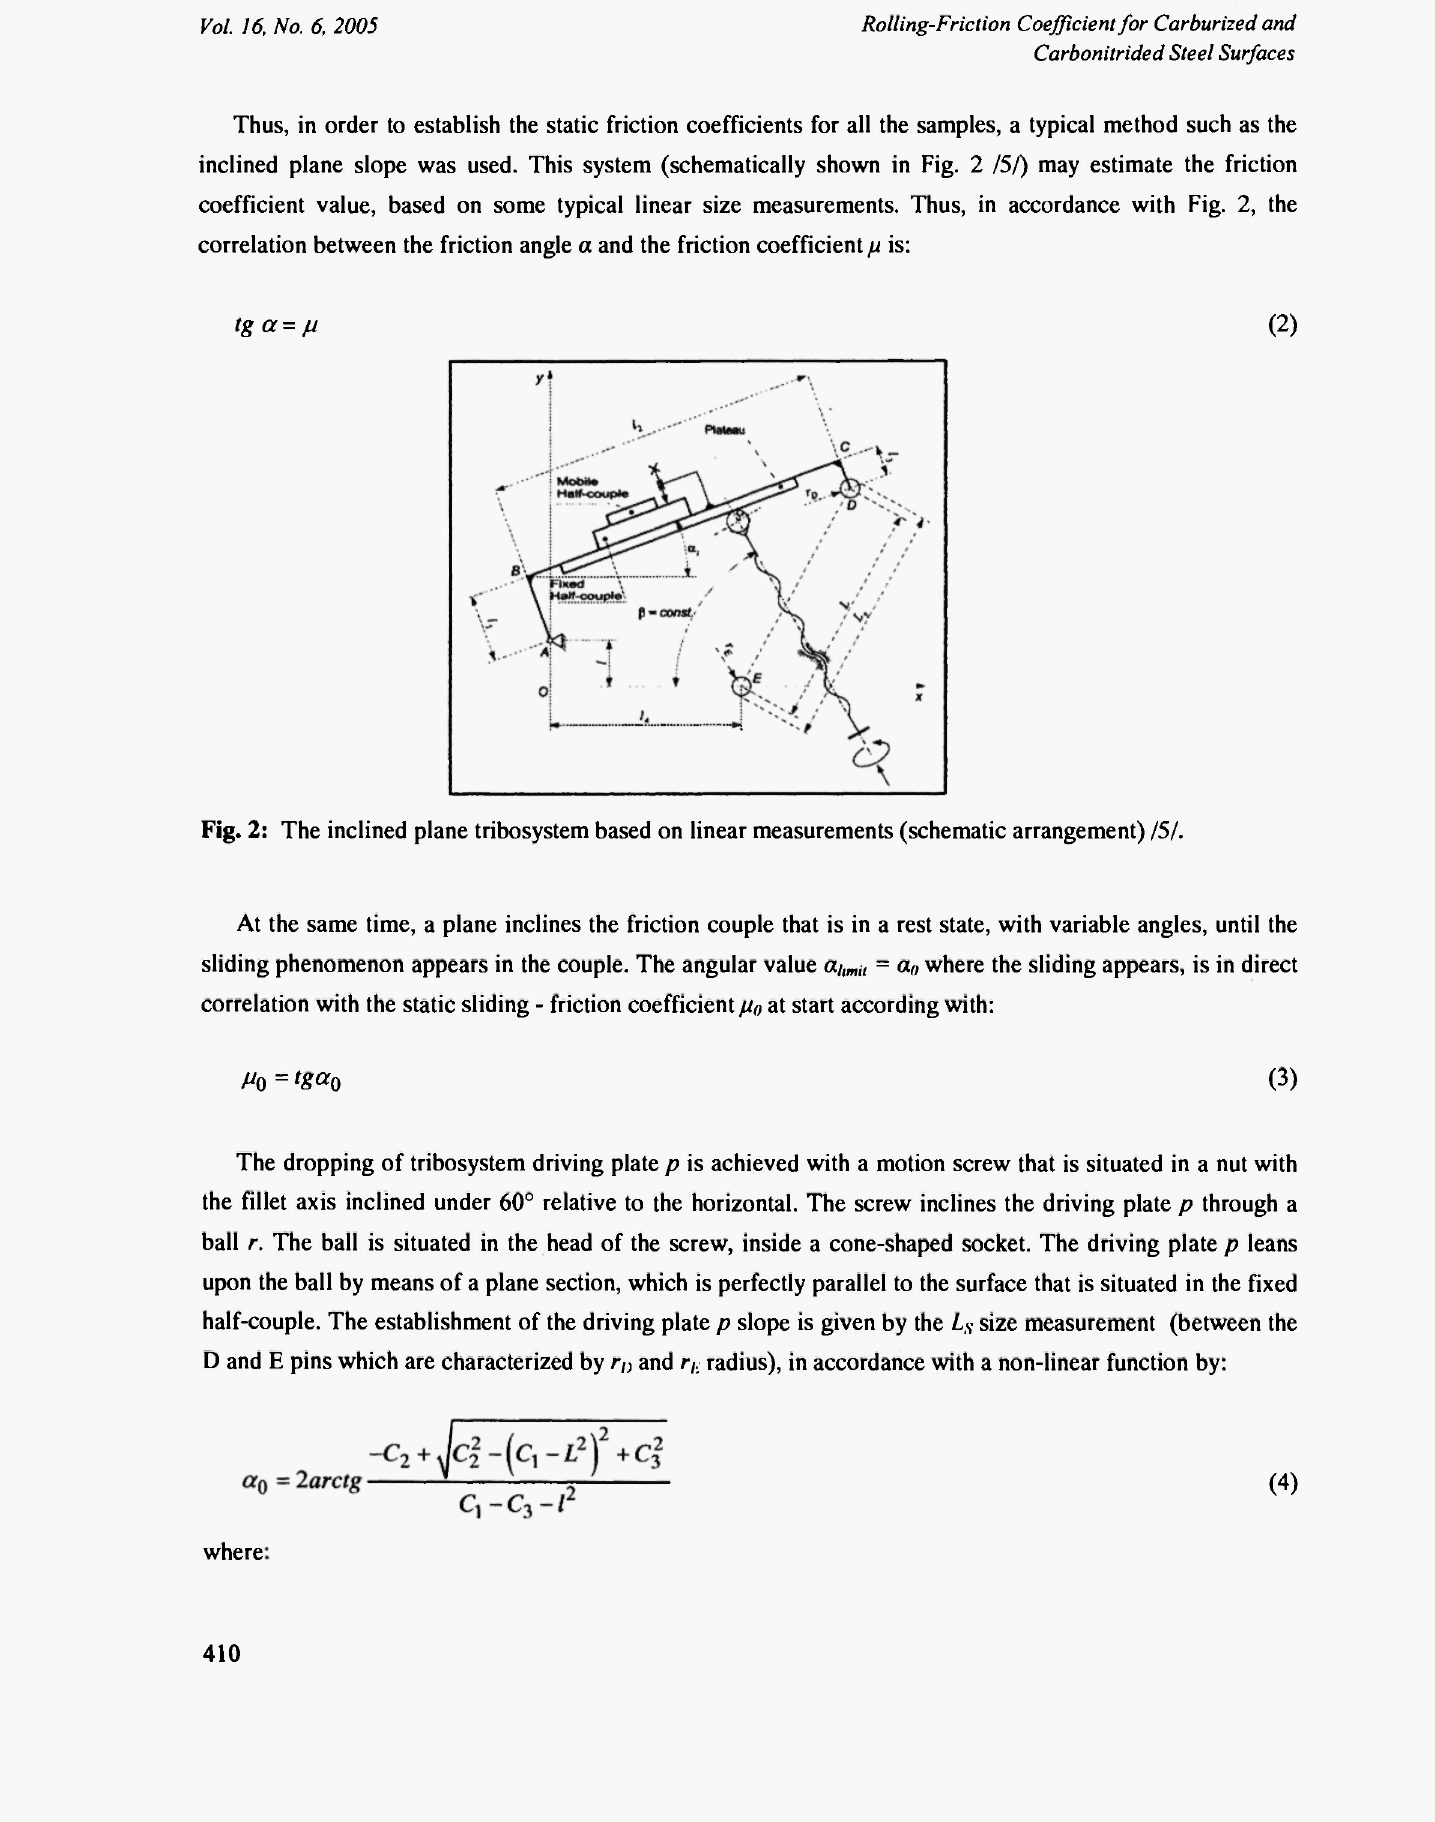
The dropping of tribosystem driving plate ρ is achieved with a motion screw that is situated in a nut with the fillet axis inclined under 60° relative to the horizontal. The screw inclines the driving plate ρ through a ball r. The ball is situated in the head of the screw, inside a cone-shaped socket. The driving plate ρ leans upon the ball by means of a plane section, which is perfectly parallel to the surface that is situated in the fixed half-couple. The establishment of the driving plate ρ slope is given by the L s size measurement (between the D and Ε pins which are characterized by r,, and r /: radius), in accordance with a non-linear function